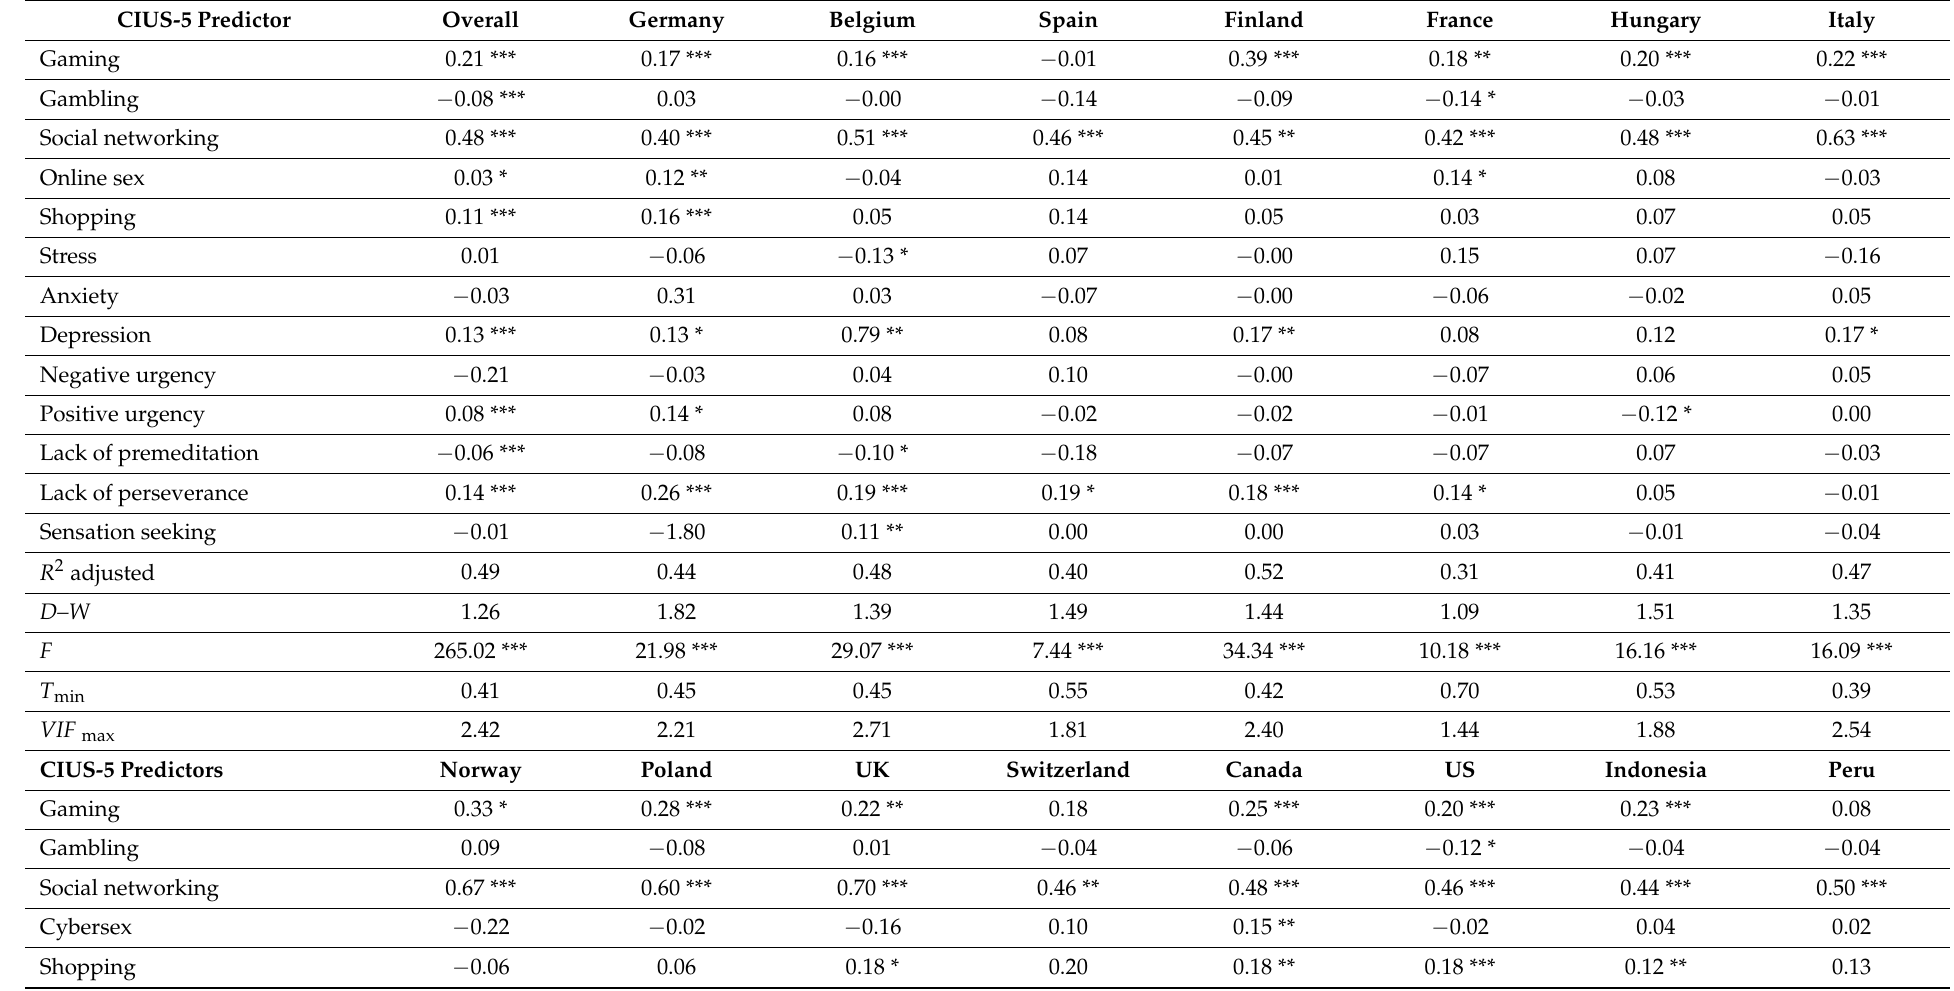
Table 5. Regression analyses predicting generalized problematic internet use regarding specific addictive online problems and psychopathology from 15 countries ( β